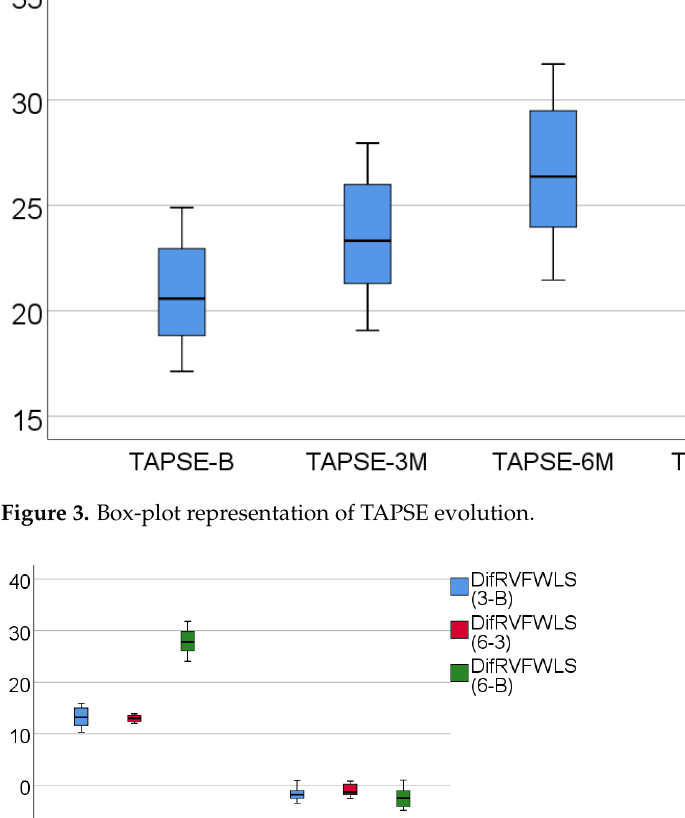
Table 3. Comparison of RVFWLS, FAC, and TAPSE evolution values in comparison to mortality.